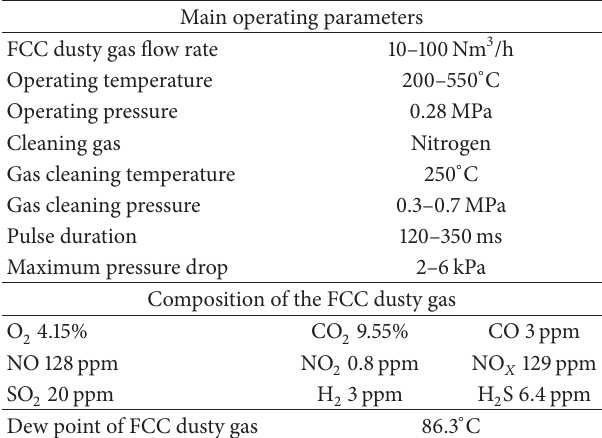
Table 1: Main operating parameters and composition of the FCC dusty